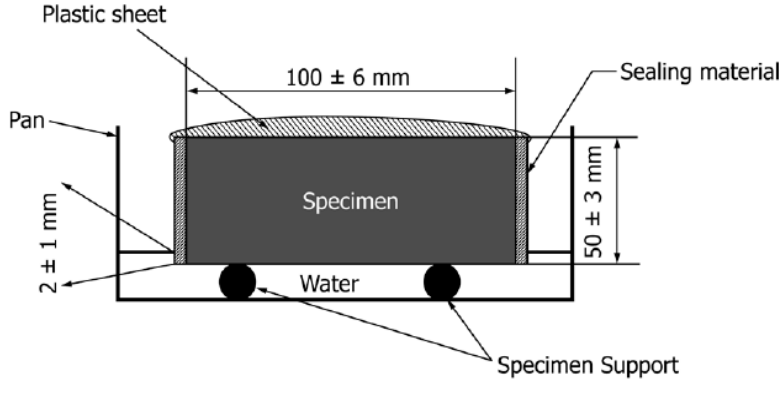
Figure 3. Schematic of sorptivity test procedure [44].